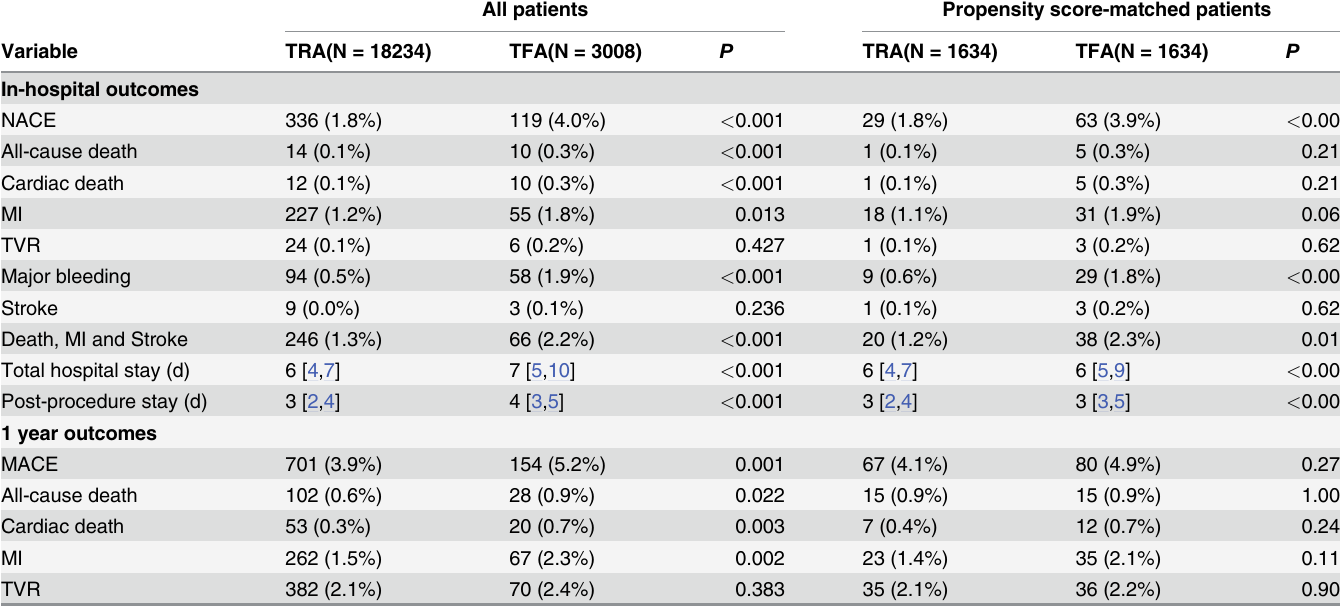
Table 3. Major outcomes. All patients Propensity score-matched